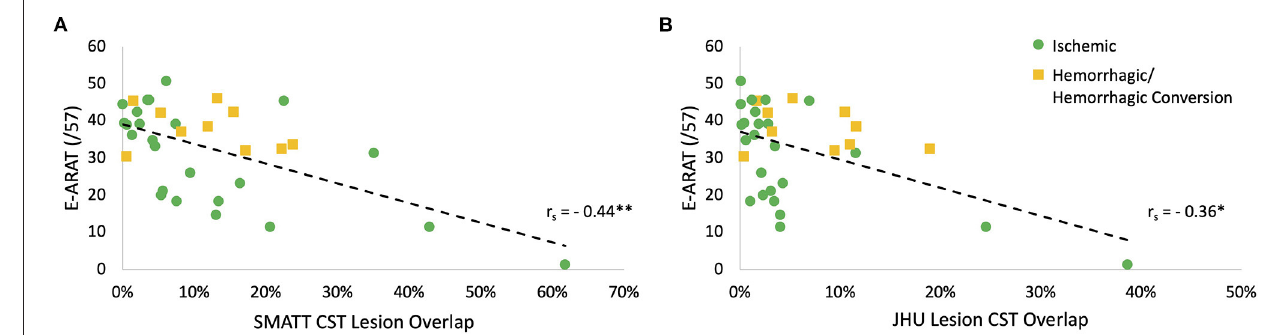
FIGURE 2 | Corticospinal tract (CST) lesion overlap is correlated with paretic upper extremity (PUE) motor outcome. (A) Sensorimotor area tract template (SMATT) CST lesion overlap is moderately correlated with estimated Action Research Arm Test (E-ARAT) score; (r s = − 0.44, n = 34, ** p = 0.0087). (B) Johns Hopkins University (JHU) atlas CST lesion overlap is weakly correlated with E-ARAT score; ( r s = − 0.36, n = 34, * p = 0.036). *Correlation is significant to the 0.05 level (two-tailed); **Correlation is significant to the 0.01 level (two-tailed).